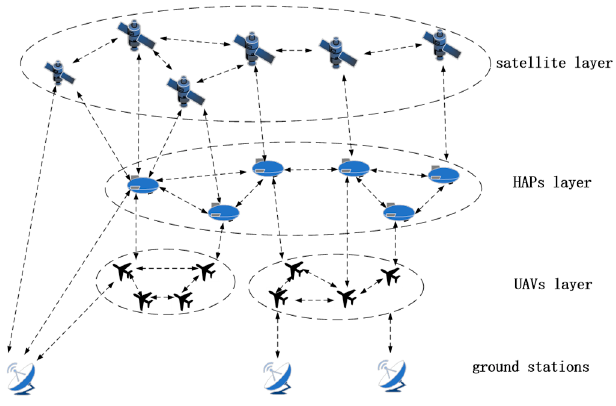
Figure 1. Multi-Layer Space Communication Network.